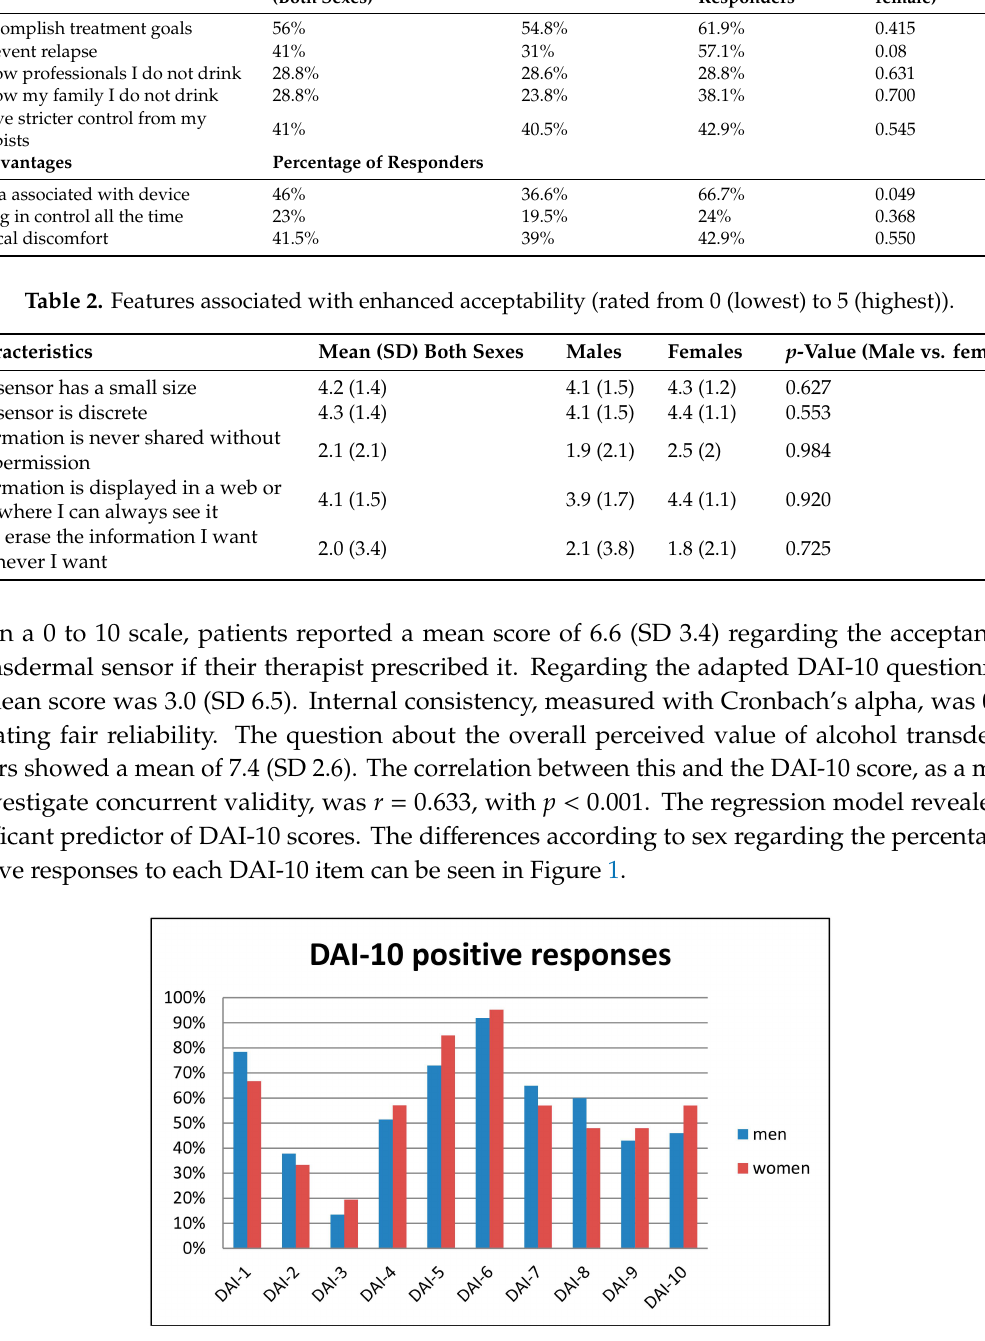
Figure 1. Percentage of positive responses to the Drug Attitude Inventory (DAI-10) questionnaire for each item and according to